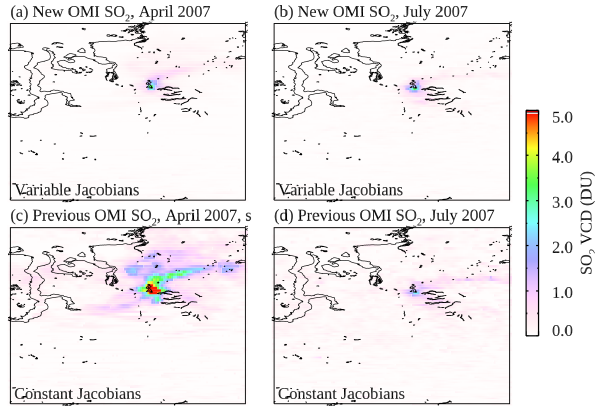
Figure 6. Monthly mean SO 2 VCDs from the new anthropogenic SO 2 dataset in OMSO2 V2 for (a) April and (b) July 2007 using pixel-specific Jacobians, showing comparable SO 2 over the area around Norilsk, Russia between the 2 months. Monthly mean SO 2 VCDs from the PBL SO 2 dataset in OMSO2 V1.3 show much greater apparent SO 2 in (c) April than in (d) July, due to the snow/ice effects that are unaccounted for with the constant Jaco- bians. Data have been filtered and gridded following the same crite- ria as in Fig.